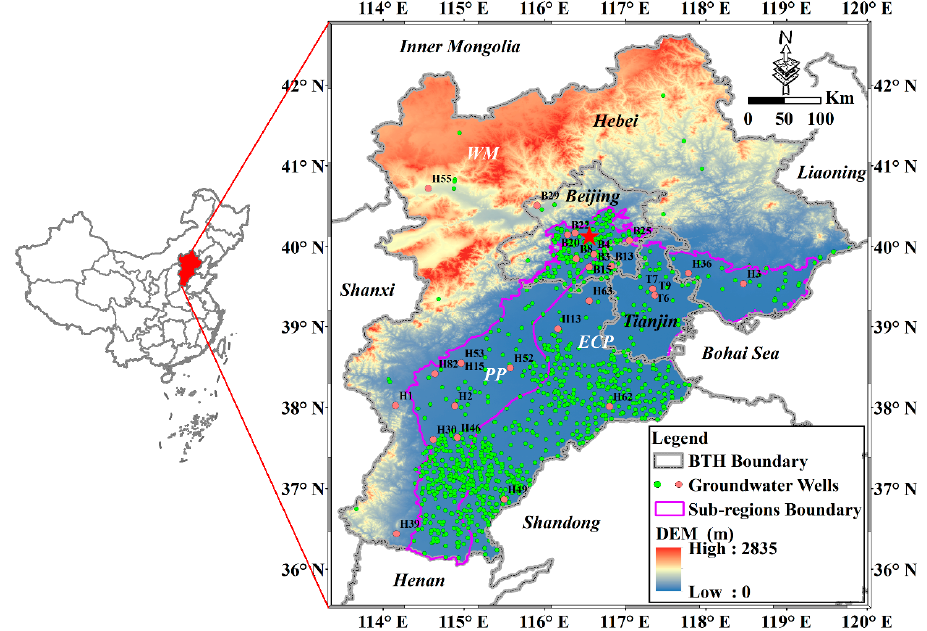
Figure 1. Location map of the BTH. The green and orange dots represent the locations of groundwater observation wells.